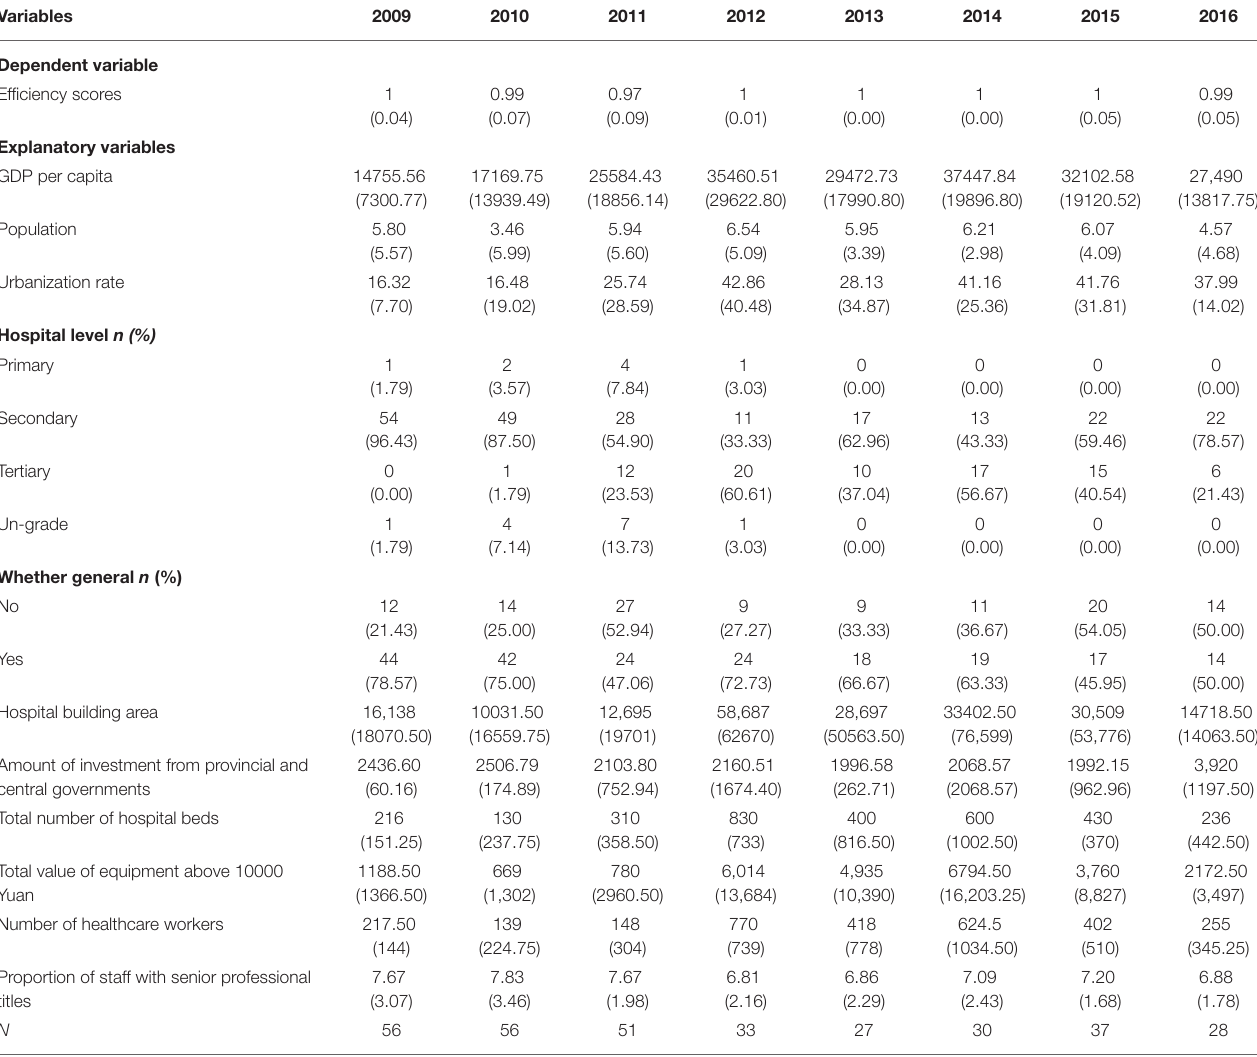
TABLE 4 | Descriptive statistics of regression